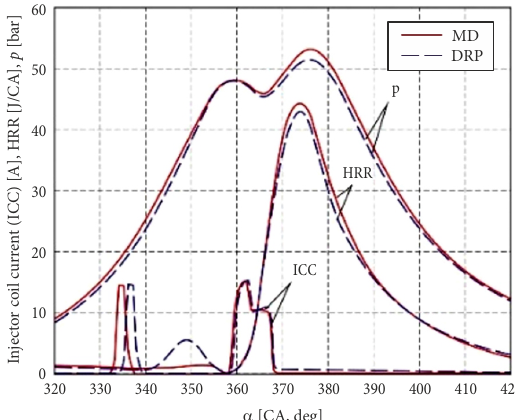
Figure 11. Injection current vs CA for MD and DRP